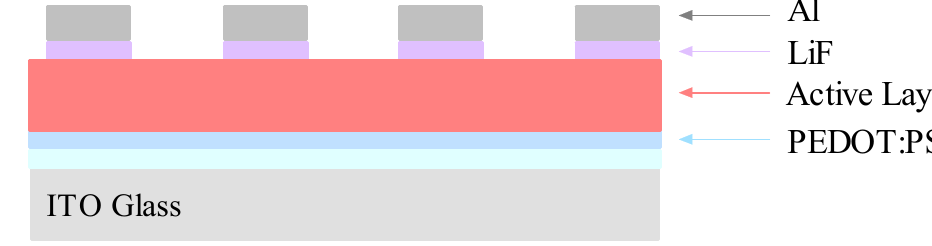
Figure 8. Diagram of the OSC showing the arrangements of the thin layers.